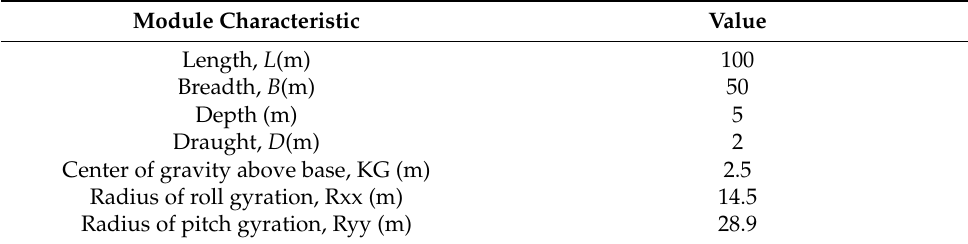
Table 1. The particulars of the single floating module in the